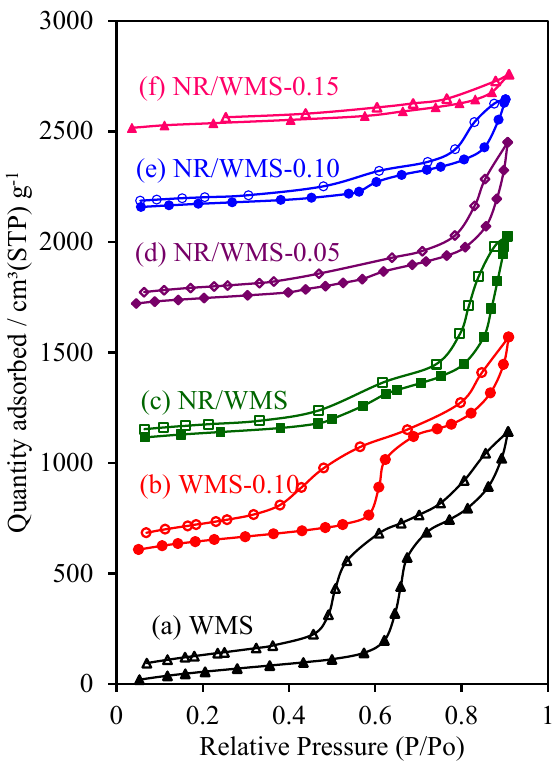
Figure 8. H 2 O adsorption–desorption isotherms of (a) WMS, (b) WMS-0.10, (c) NR/WMS, (d) NR/WMS-0.05, (e) NR/WMS-0.10 and (f) NR/WMS-0.15.